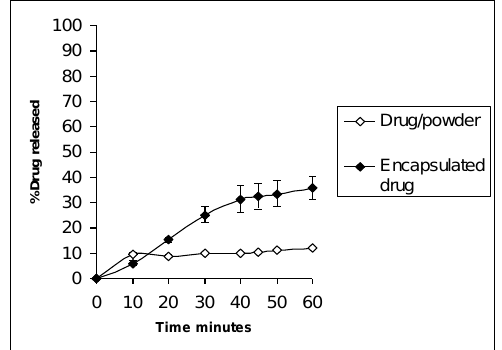
Figure 1: Effect of gelatin shell on the dissolution of piroxicam in 0.1 N HCl at